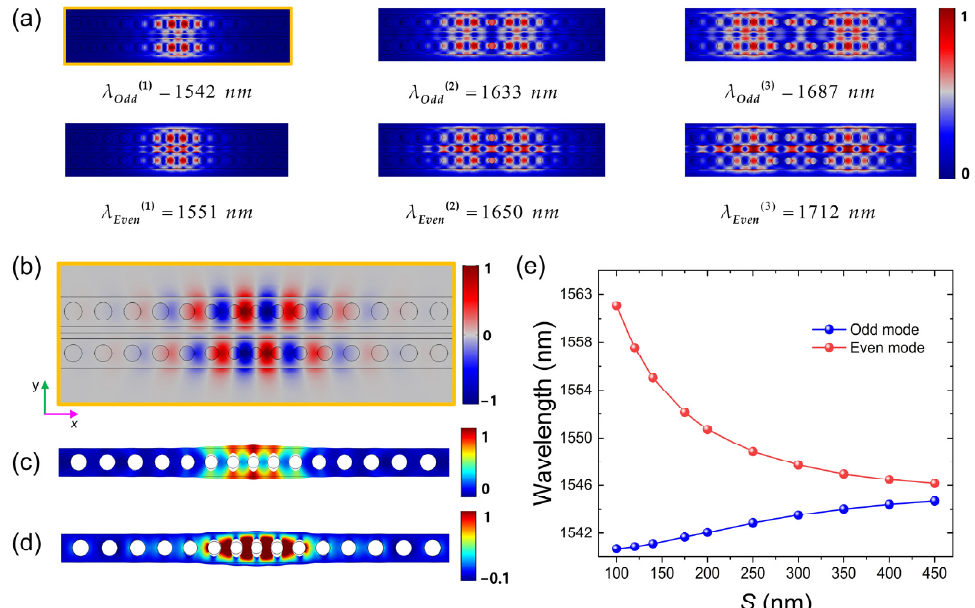
Figure 2. ( a ) Normalized amplitude of electric field |E| for various orders of even and odd optical modes. ( b ) Normalized electric field component E y of first-order optical odd mode. ( c ) Normalized amplitude of displacement field of 5.635 GHz mechanical breathing mode in an arm of zipper cavity. ( d ) Strain tensor component S yy for mechanical breathing mode. ( e ) Optical resonant wavelengths of the first-order even and odd mode versus gap length s . ( a – e ) Both the mechanical modes and the optical modes are simulated via the finite element method.